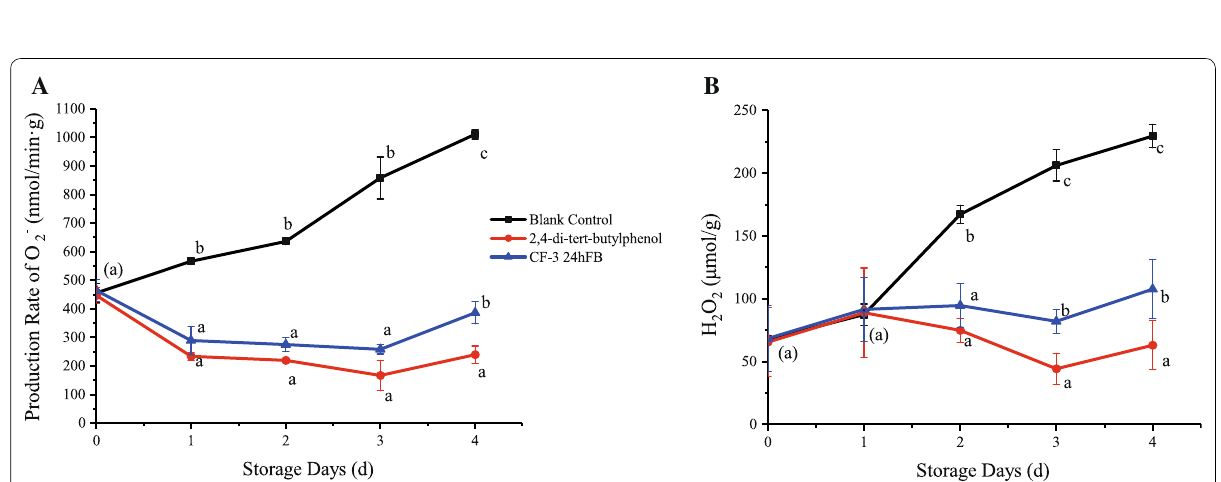
Fig. 4 Influence of different treatments on the production rate of superoxide anion ( A ) and the amount of hydrogen peroxide ( B ) produced in vivo during storage. The mean and standard errors in the figure were taken from three replicates, and different letters indicate that different treatments in the same storage days were significantly different ( P < 0.05